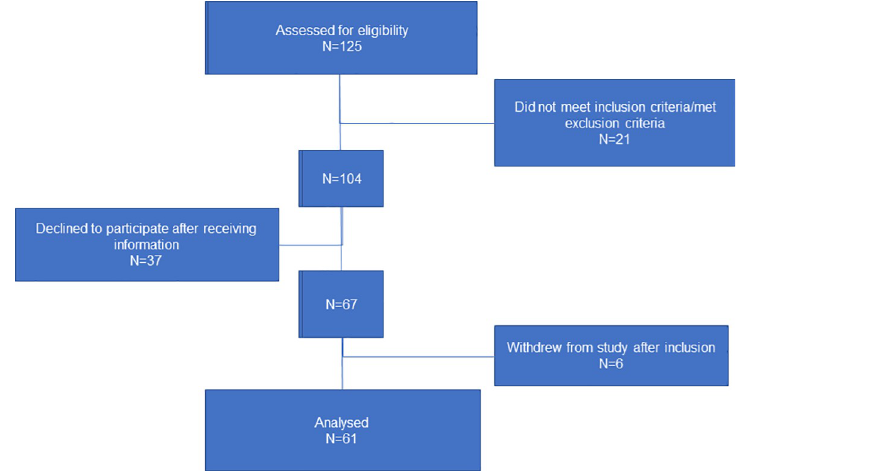
Fig 1. Flowchart of enrollment of pregnant women in the